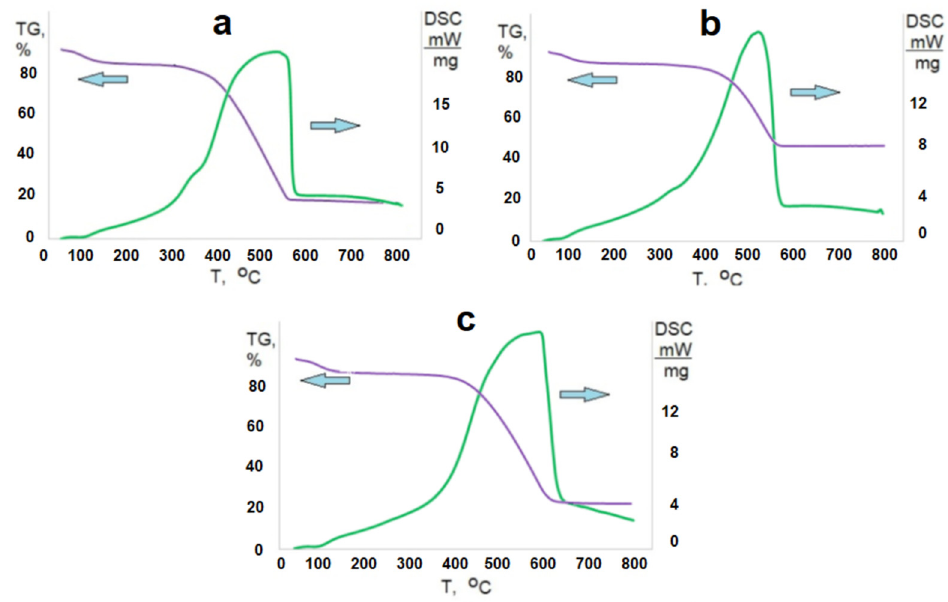
Figure 5. TG and DSC data for synthesized composites: ( a ) is FS, ( b ) is FR, and ( c ) is FP.